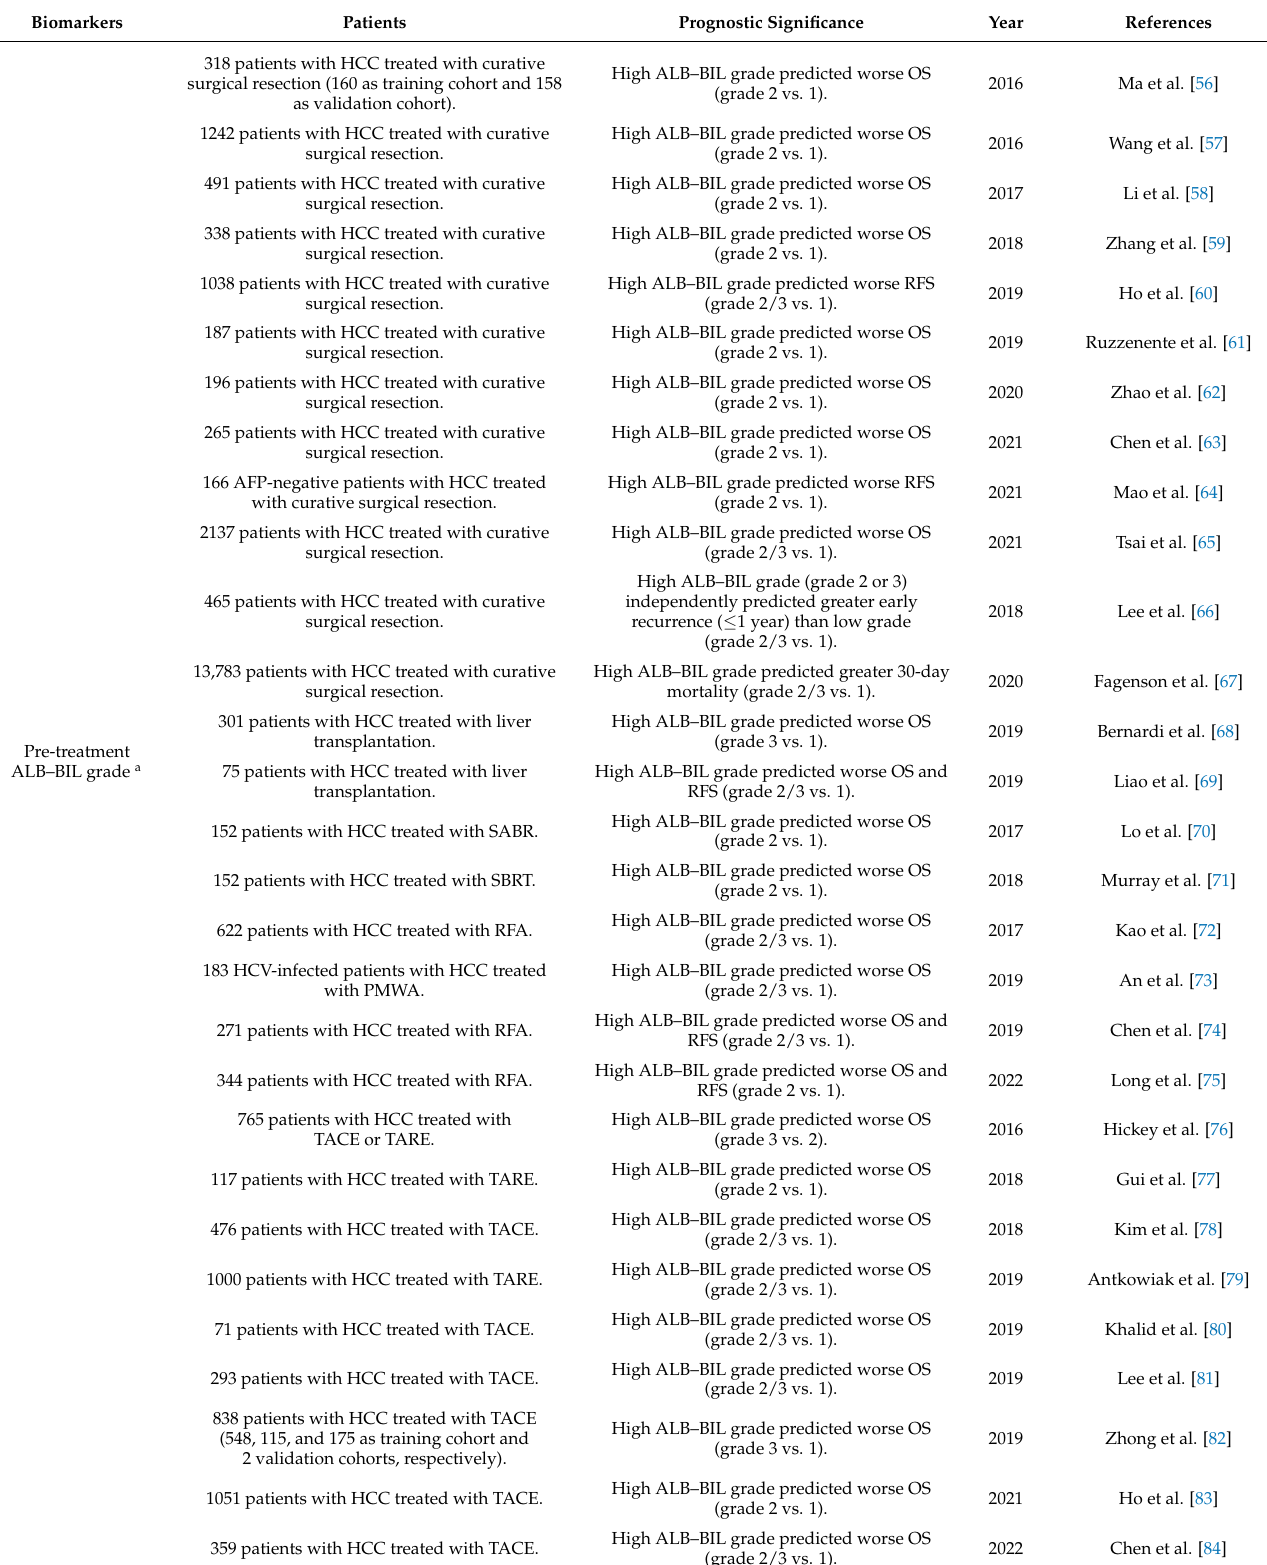
Table 5. Prognostic significance of serum ALB–BIL grade in HCC